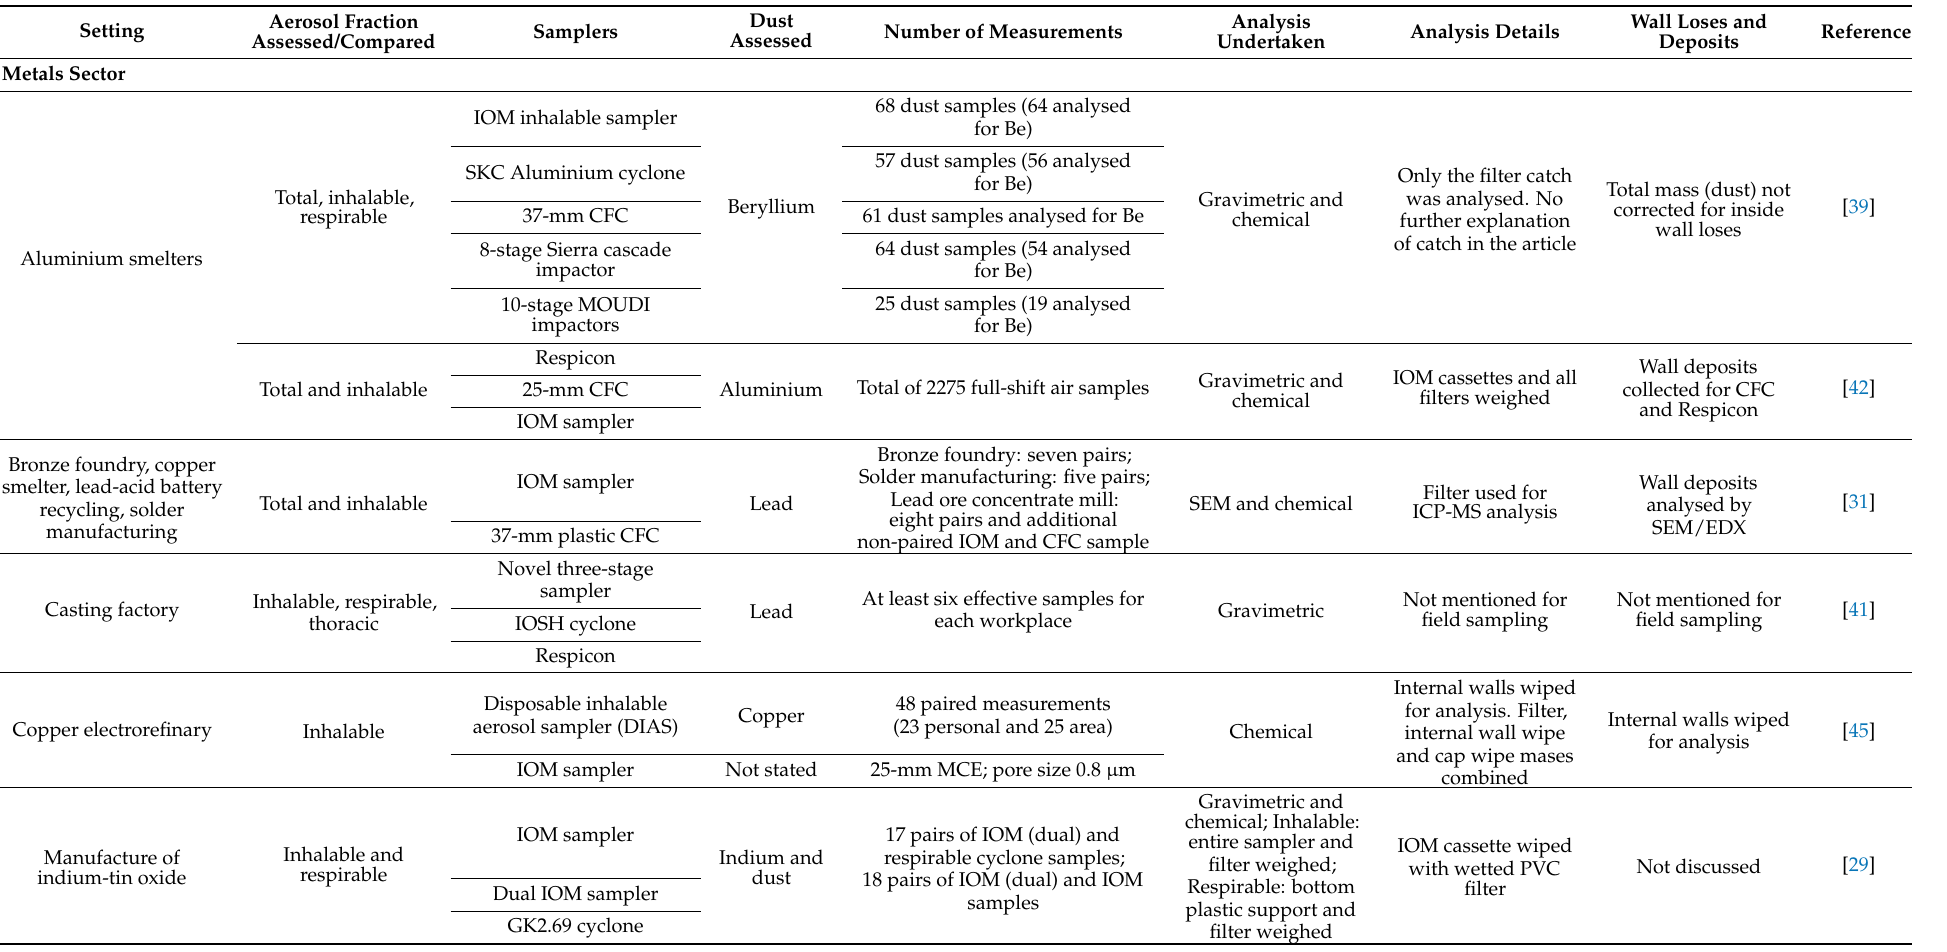
Table A3. Workplace based sampler comparison article